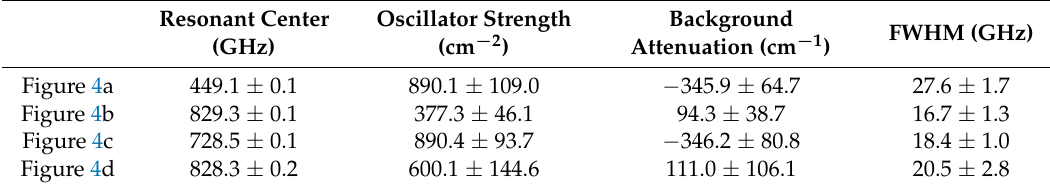
Table 1. The fitting parameters of each Lorentz curve in Figure